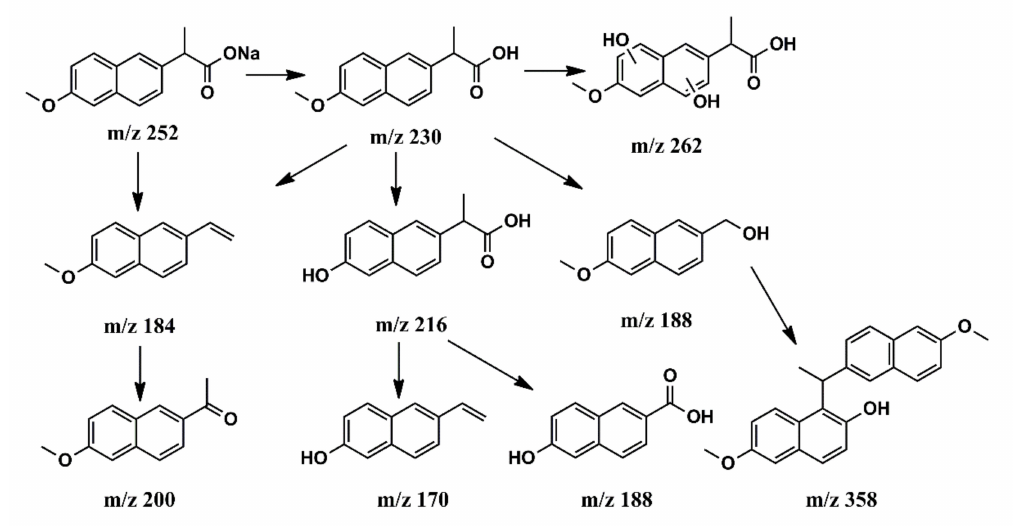
Figure 9. Proposed photodegradation pathways for NPX by rGO / ZIS-1. Reaction conditions: [NPX] = 10 mg · L − 1 , [photocatalyst] = 0.2 g · L − 1 , natural pH, λ > 420